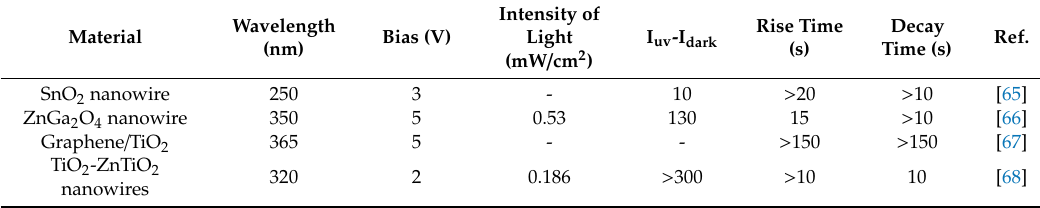
Table 3. Comparison of performances for various material-based UV